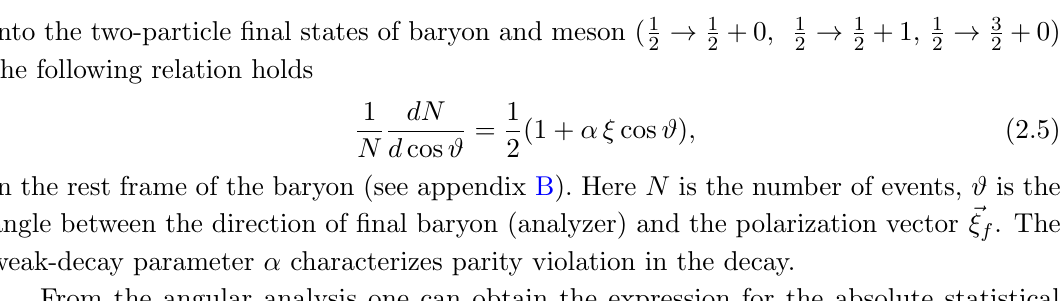
Figure 1 . Schematic layout of experiment. E(cid:11)ective electric (cid:12)eld ~E is orthogonal to the momentum ~p . The (cid:12)gure shows the case g >